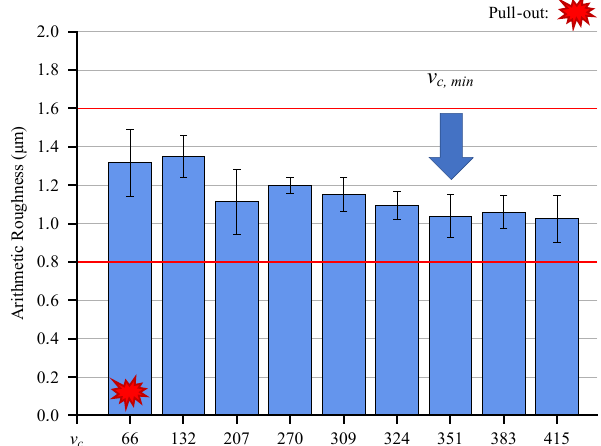
Figure 18. Determination of the minimal cutting speed of the composite tool, evolution of the arithmetic roughness (µm) for different v c (m/min) with f z = 0.030 mm/tooth, a p = 3 mm, and a e = 0.5 mm.